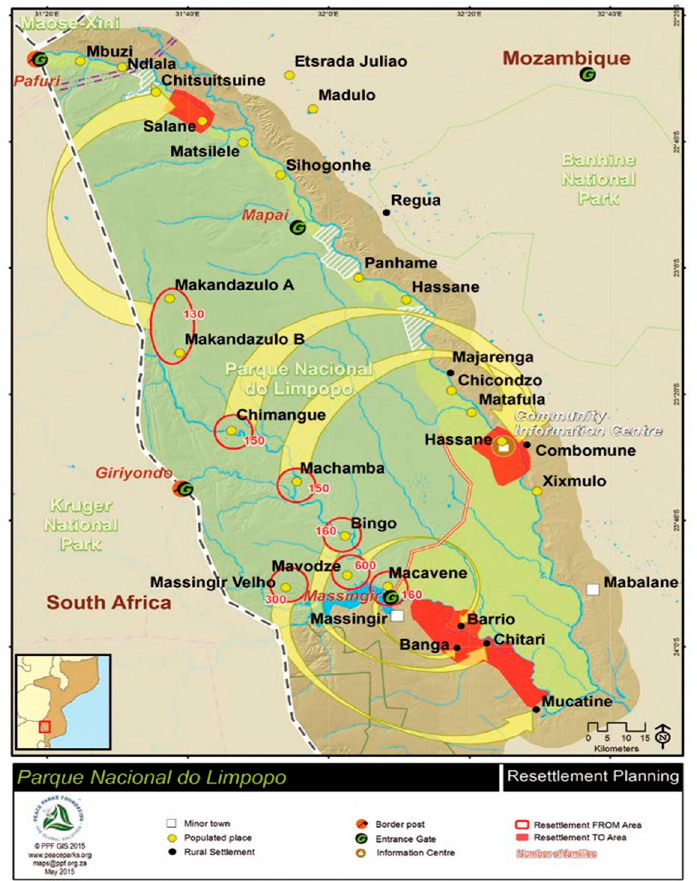
Figure 1. Massingir District: LNP (Limpopo National Park), buffering zone, dam, biofuel project area, and resettlement areas [14]. The LNP is represented by the dark green color and the buffering zone of the park by the light green color. Massingir Dam is located at the entrance gate of the park, right next to the minor town of Massingir. The arrows point out the areas in which each community inside the park was resettled. The Procana project was to be implemented in the red area surrounding Massingir minor town and the Dam (Banga, Barrio, and Chitari area).